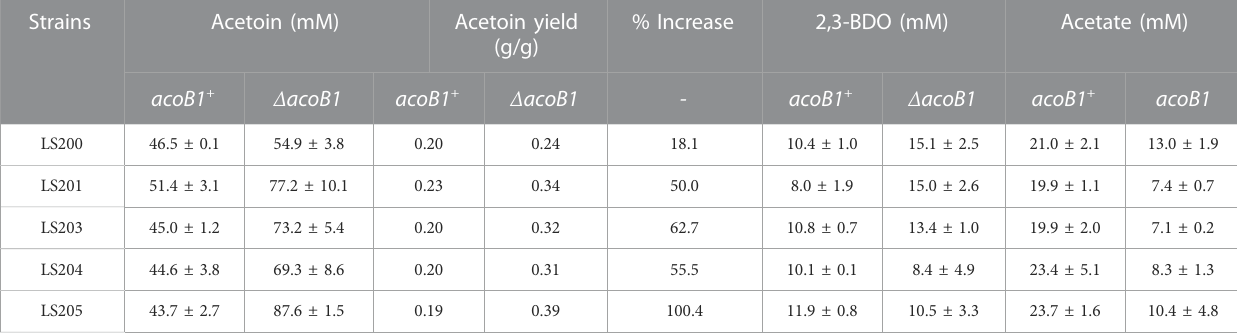
Strains were cultured for 48 h in 2 mL of M-ASYE, media containing 2% (w/v) of glucose and yeast extract in 50 mL falcon with shaking (250 rpm) at 50 ° C. error bars represent standard deviation of three biological